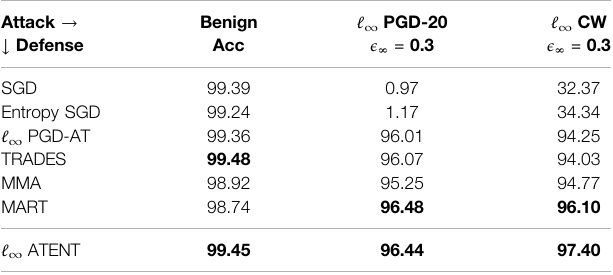
TABLE 2 | Robust accuracies (in percentages) of 5-layer convolutional net for MNIST against ℓ ∞ , ϵ (cid:1) 0.3 attack. Attack → Benign ℓ ∞ PGD-20